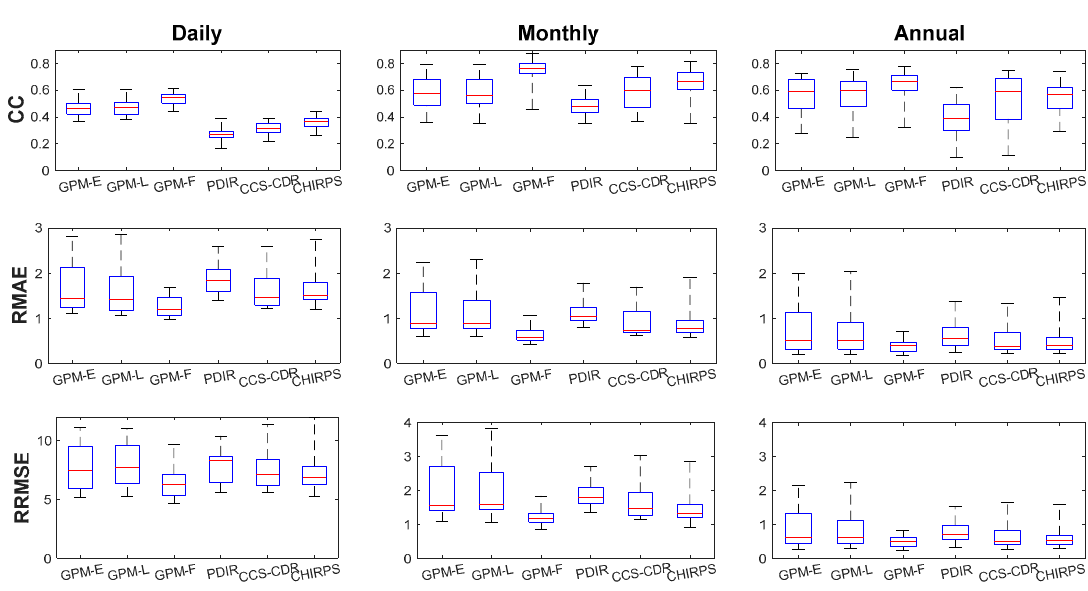
Figure 3. Boxplot of three continuous metrics at daily, monthly and annual time scales.